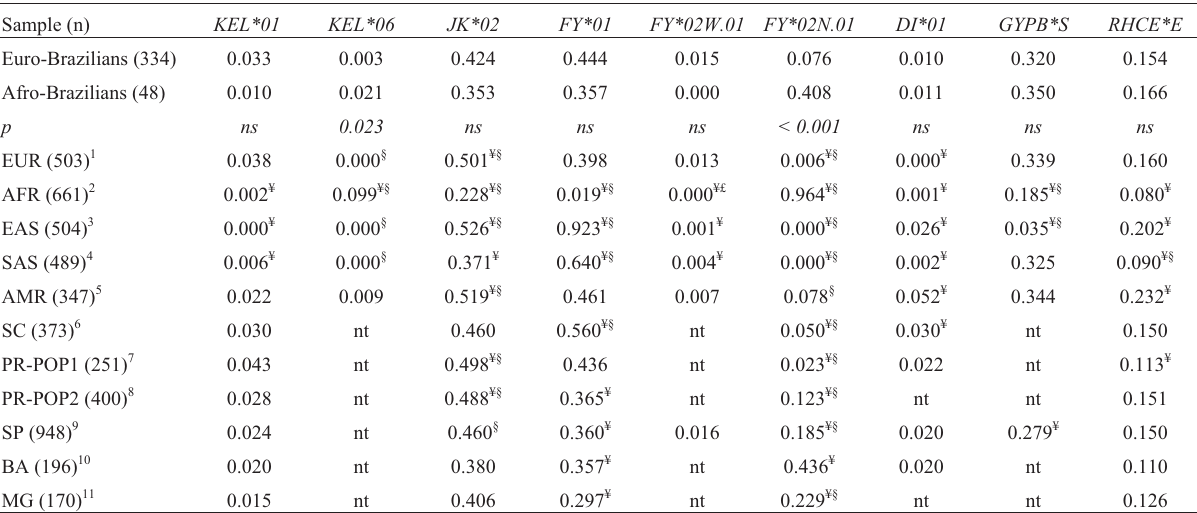
Table 2 - Minor allele frequencies of blood groups variants in Euro and Afro-Brazilians from Rio Grande do Sul, 1000 Genomes Database and previous studies performed at